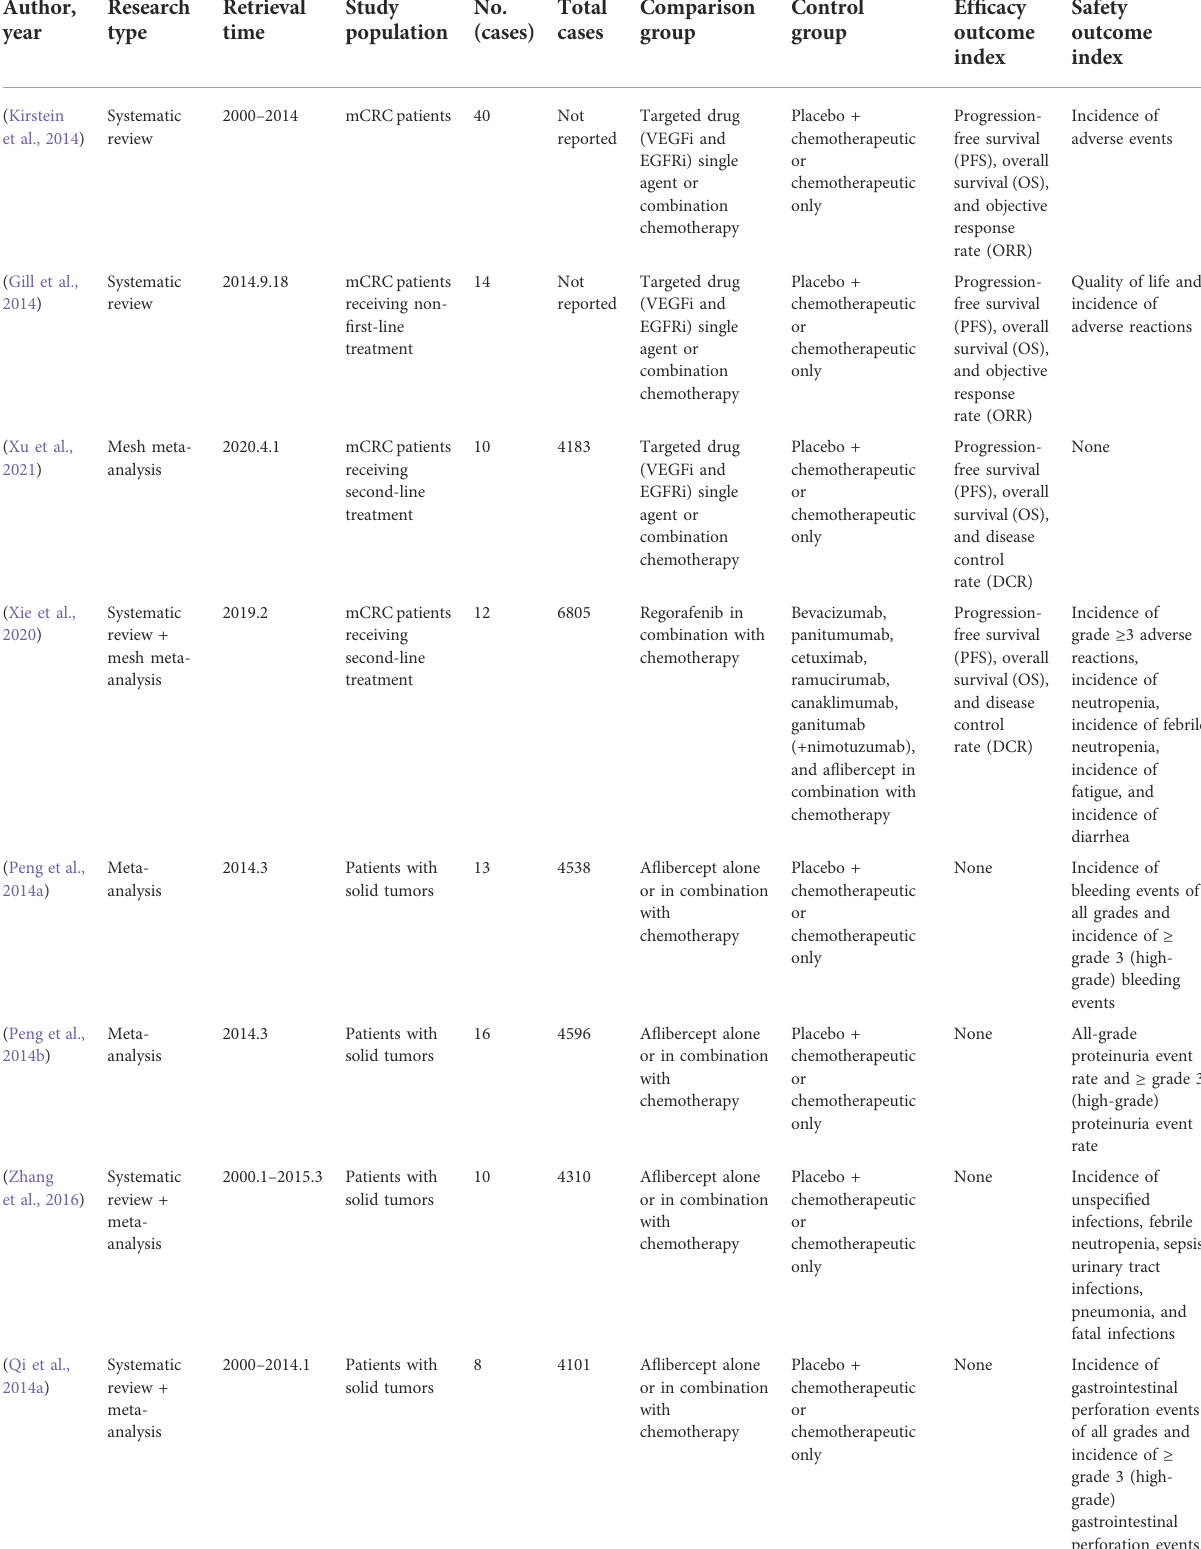
TABLE 3 Data extraction of included